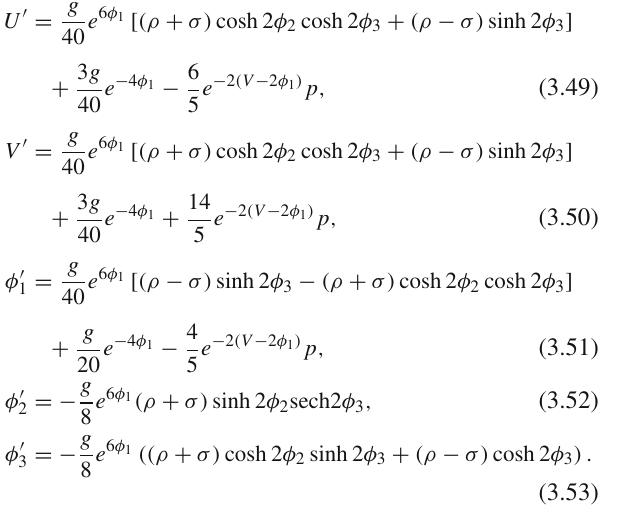
, − 1 , − 1 , − 1 , 36 48 64 86